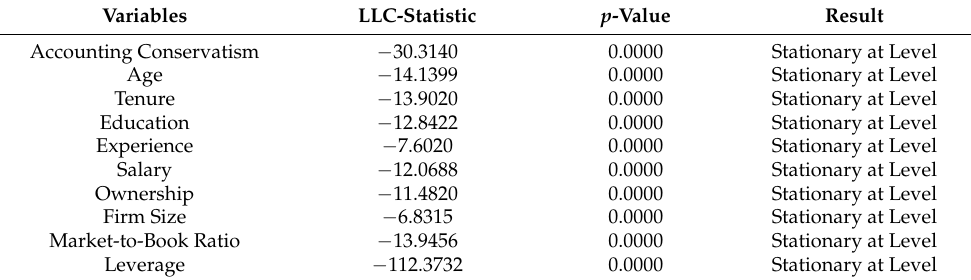
Table 5. The results of stationary tests.